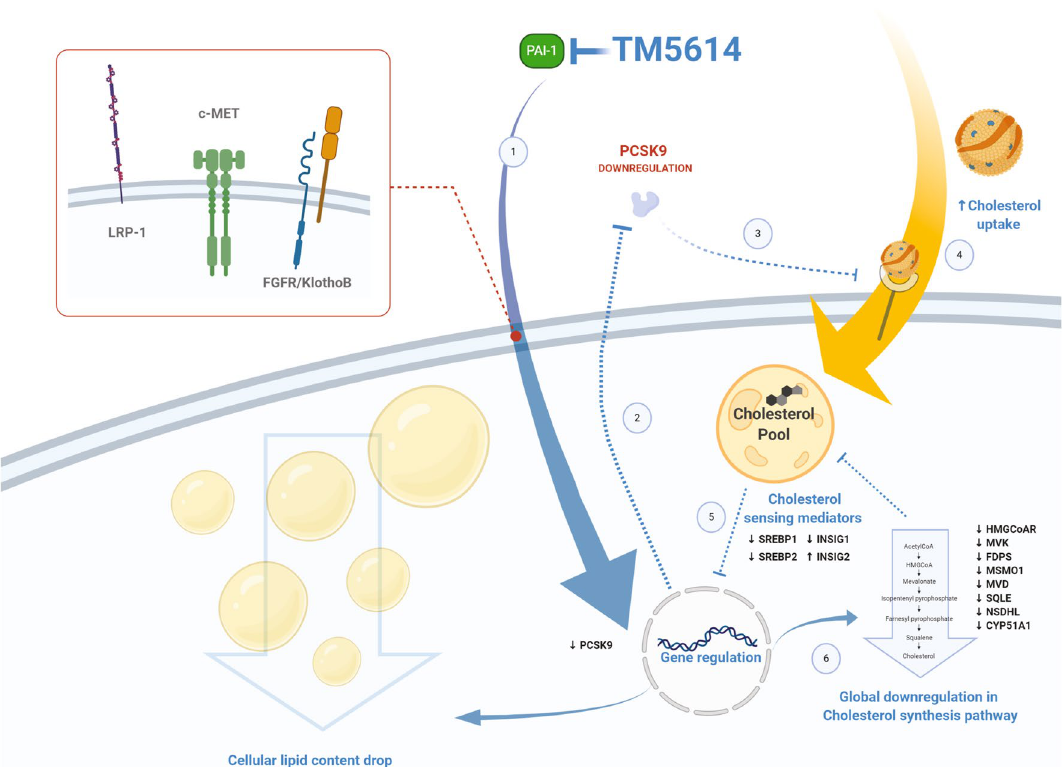
Figure 6. PAI-1 inhibition triggers a lipid-lowering effect mediated by PCSK9 downregulation. As TM5614 inhibits PAI-1 activity, hepatic PCSK9 is downregulated at the transcriptional level (1). Consequently, plasma levels of PCSK9 decrease (2). Lower plasma PCSK9 levels exert a lower impact on catabolism of the LDL receptor (3), enabling the receptor to clear larger amounts of LDL-C from the circulation (4). The increase in intracellular cholesterol triggers the translocation of cholesterol sensing factors to the nucleus (5) to downregulate the transcription of genes involved in lipid metabolism (6). LRP-1, c-MET or FGFR/KlothoB are potential mediators for the observed effect. Animation created with https ://biore